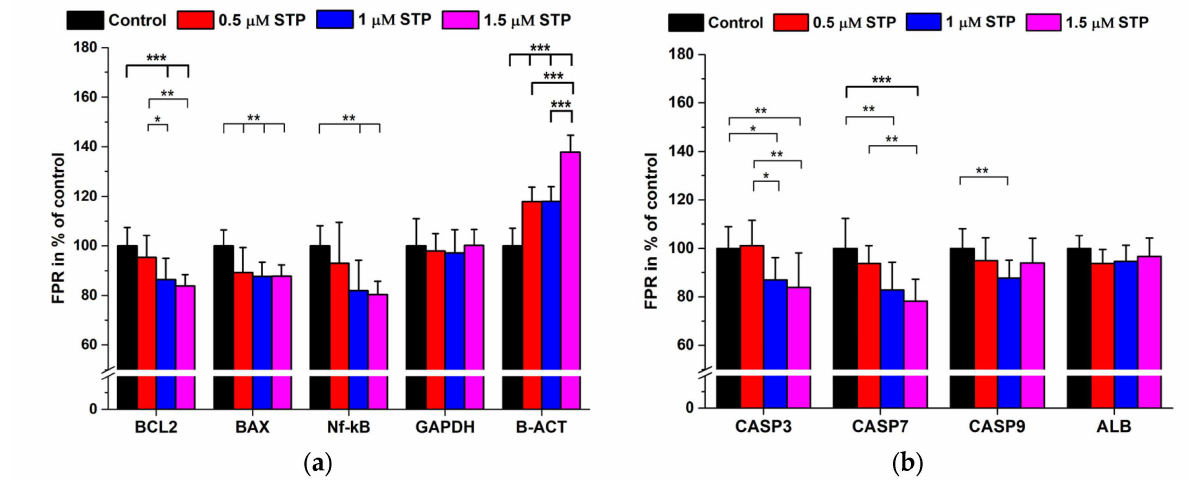
Figure 5. Apoptosis signal protein expression in STP (0–1.5 µ M) treated HepG2 cells. ( a , b ): data are expressed as FPR in % of the controls (N = 6 × 4). *: p < 0.05, **: p < 0.01, ***: p <